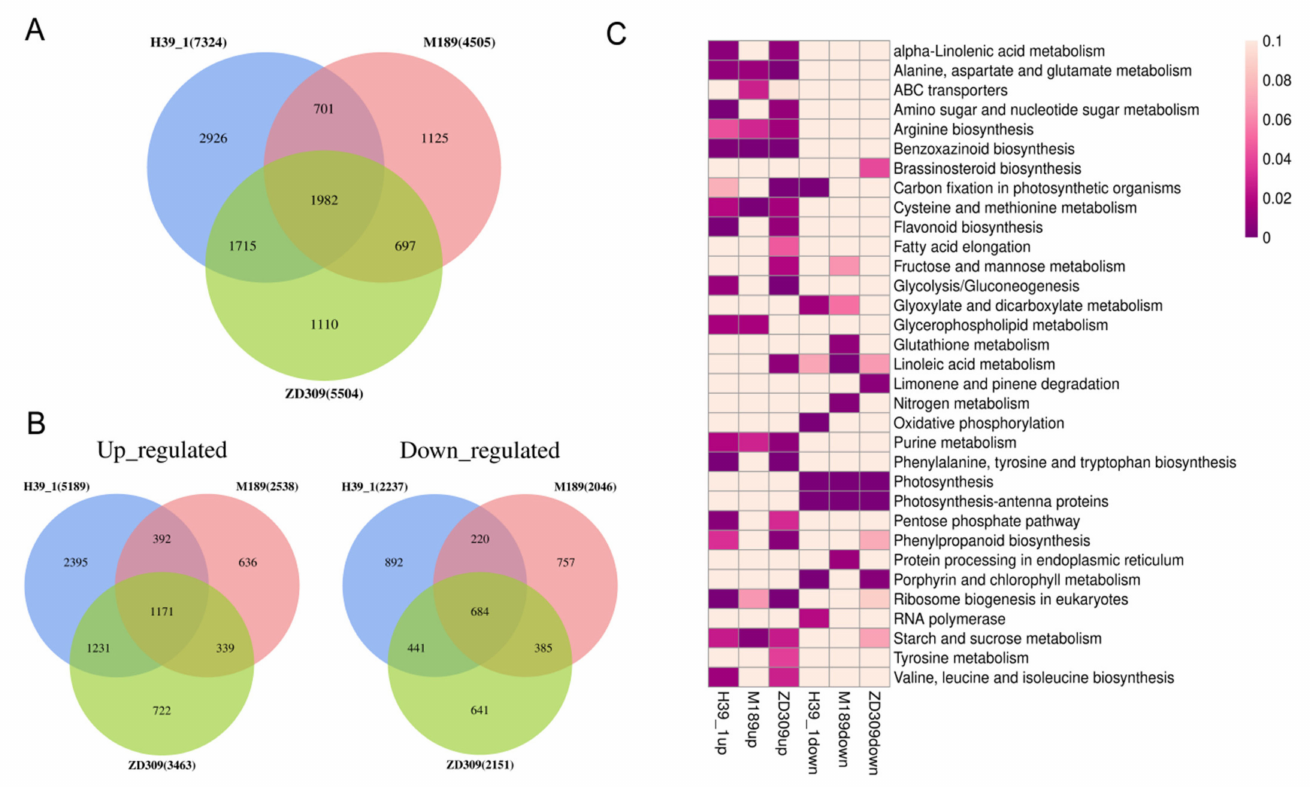
Figure 6. Comparison of the identified DEGs in ZD309 and its parental lines. ( A ) Numbers of DEGs of ZD309 and its parental lines in D3HS or D6HS treatment. ( B ) Numbers of up- and down-regulated DEGs of ZD309 and its parental lines in D3HS or D6HS treatment. ( C ) KEGG enrichment analysis for the up- and down-regulated DEGs in each genotype. The heatmap presents statistical significance ( p -value) of KEGG pathway term